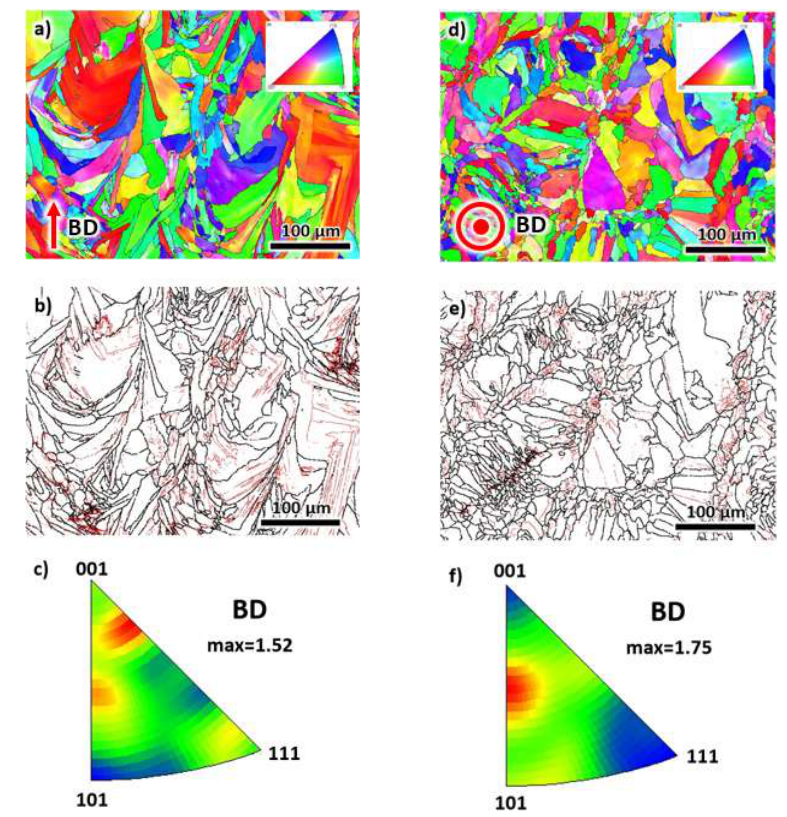
Figure 6. The ( a ) EBSD IPF-Z map, ( b ) the grain boundary distribution map, and ( c ) the IPF representation of the grains of annealing heat-treated 316L samples taken from the building direction. Similarly, the ( d ) EBSD IPF-Z map, ( e ) the grain boundary distribution map, and ( f ) the IPF representation of the grains of the annealing heat-treated samples taken from the transverse direction.